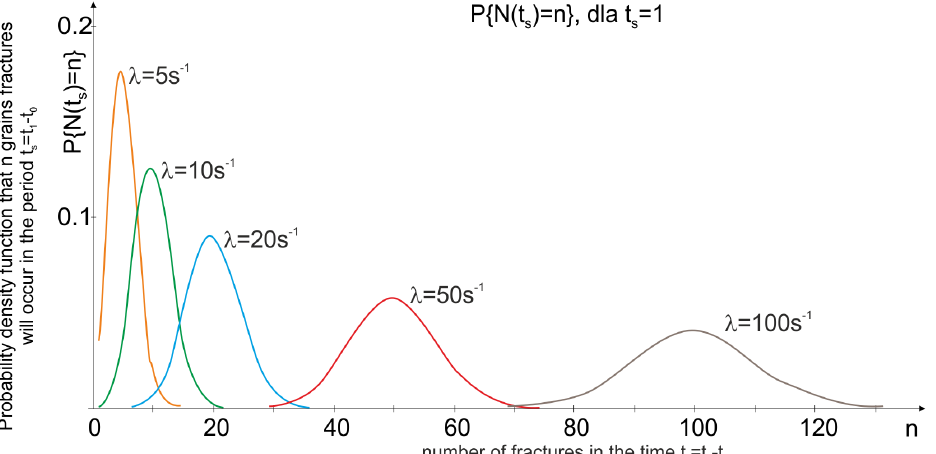
Figure 3. Probability density function that n grain fractures will occur in the period t s = t 1 − t 0